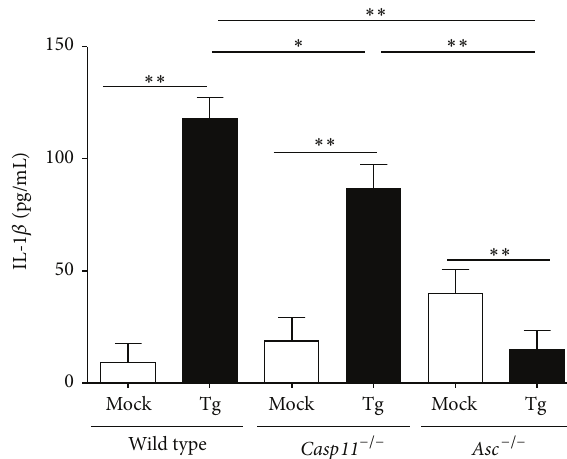
Figure 1: IL-1 𝛽 levels are ablated in macrophages harvested from Casp11 −/− and Asc −/− mice following ex vivo infection with Tox- oplasma gondii . Bone marrow derived macrophages were primed with 100ng/mL of LPS for 30 mins prior to stimulation with either Toxoplasma gondii Me49 (MOI = 1) or vehicle for 24 hrs. IL-1 𝛽 levels in cell-free supernatants were quantified using ELISA. ∗ 𝑝 < 0.05 ; ∗∗ 𝑝 < 0.01 . Data shown are representative of 3 independent experiments utilizing 2 mice per